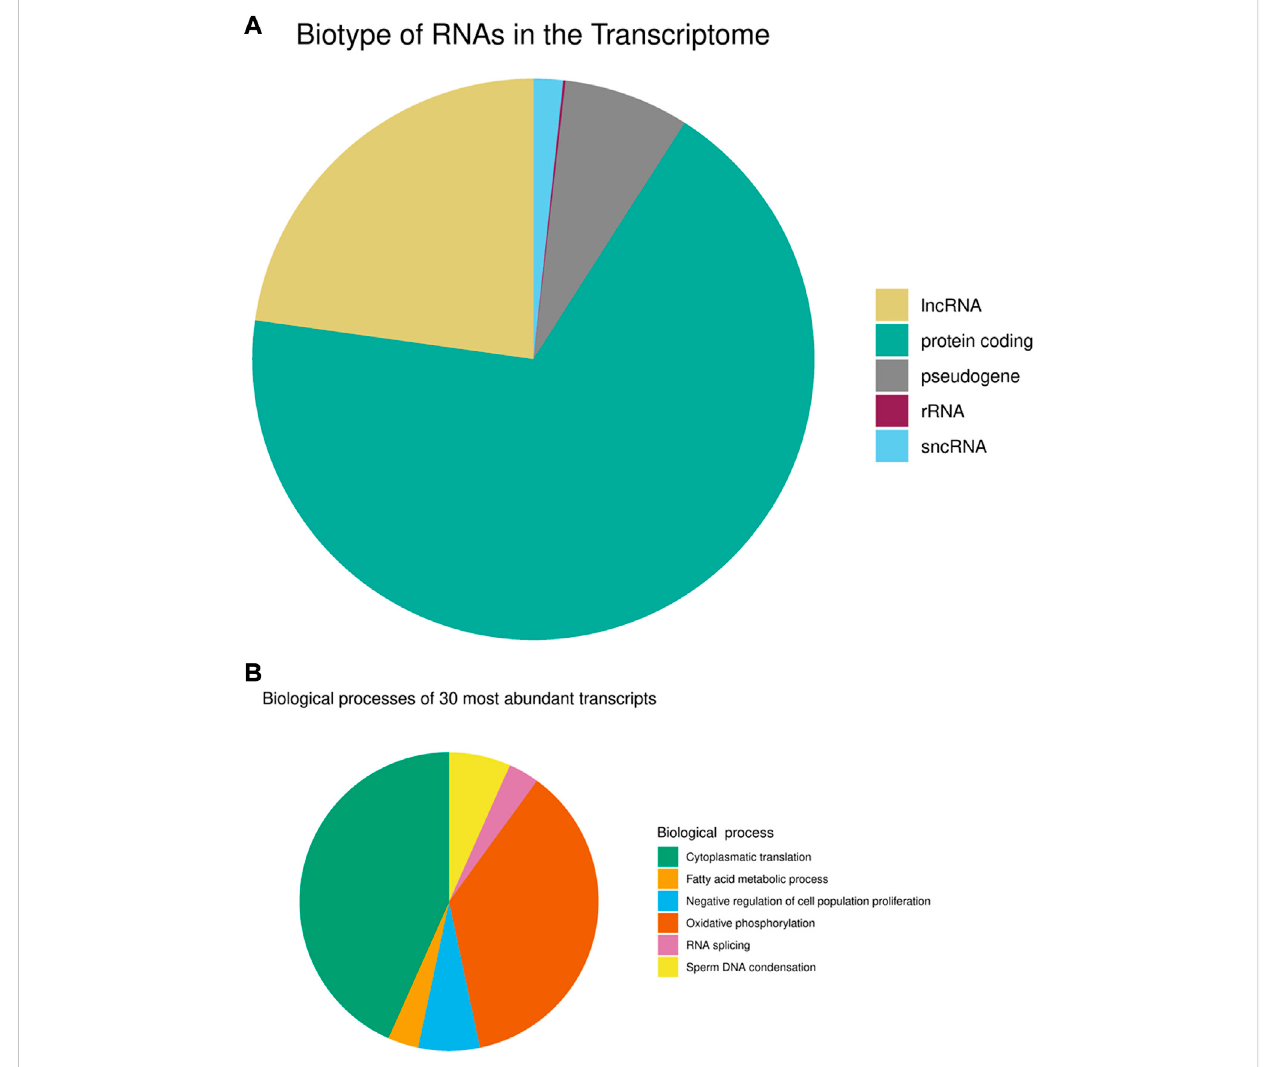
TABLE 2 Basic analysis of the DRIP-Seq experiments. Error shows ±standard error of the mean (SEM) among the biological replicates. Number of peaks Coverage of peaks [Mbp] Average GC content